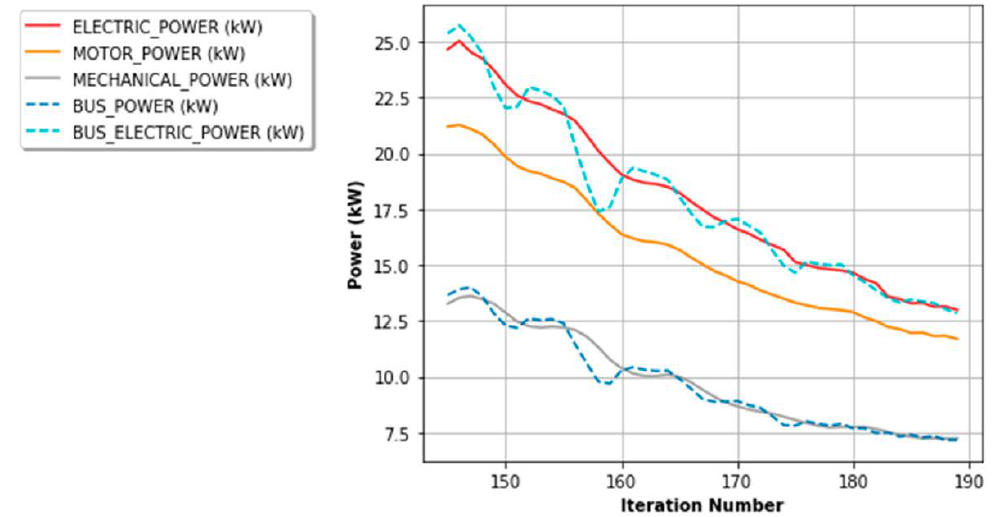
Figure 16. Deceleration section with changing slope.